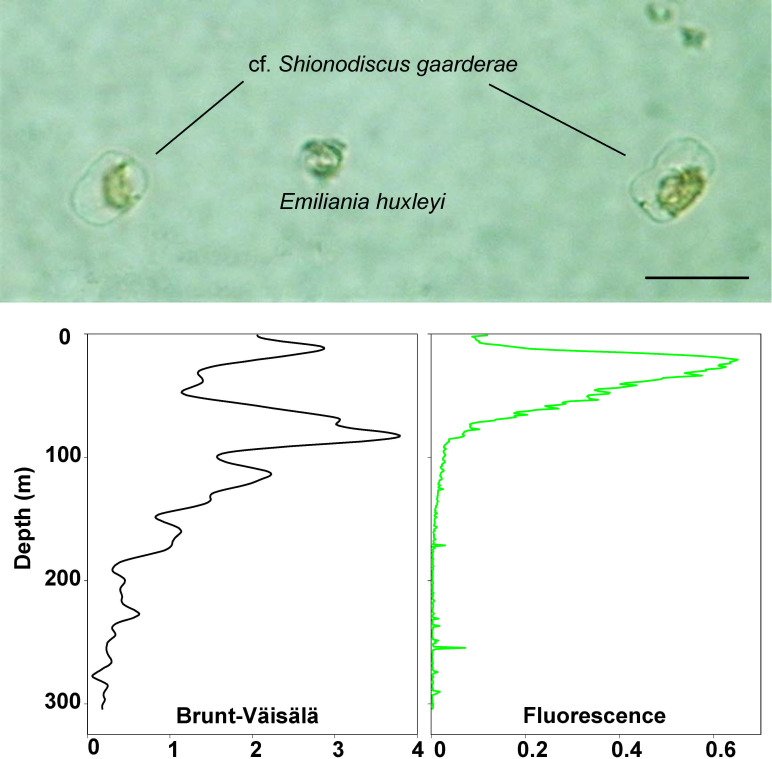
Dominant blooming species and water column structure at station 17.The photography shows two weakly silicified cells of the small diatom cf. Shionodiscus gaarderae (biovolume: 2828 μm3, carbon content: 181 pg C cell-1), and a cell of the coccolithophore Emiliania huxleyi. Scale bar: 15 μm. In the lower panels, the vertical profiles of water column stability (Brunt-Väisälä parameter, in cyc h-1) and the fluorescence at station 17 are shown.